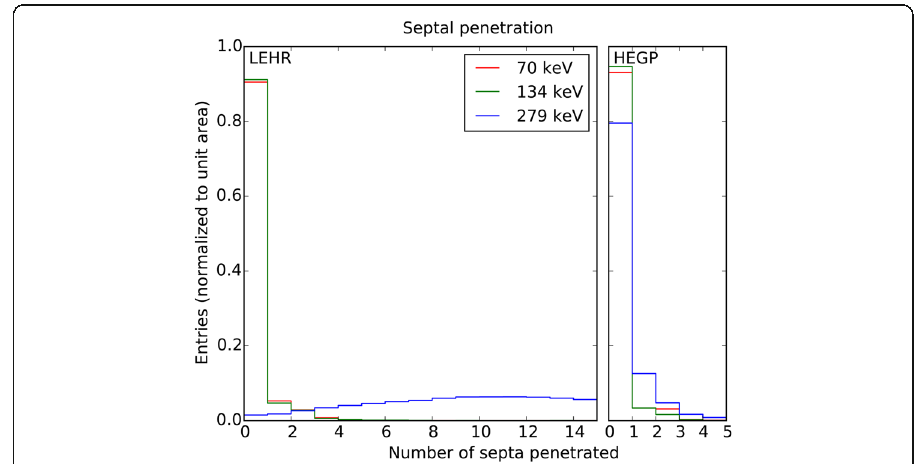
Fig. 9 Septal penetration. Distributions of number of penetrated septa for both collimators and detected photons of three simulated emission energies